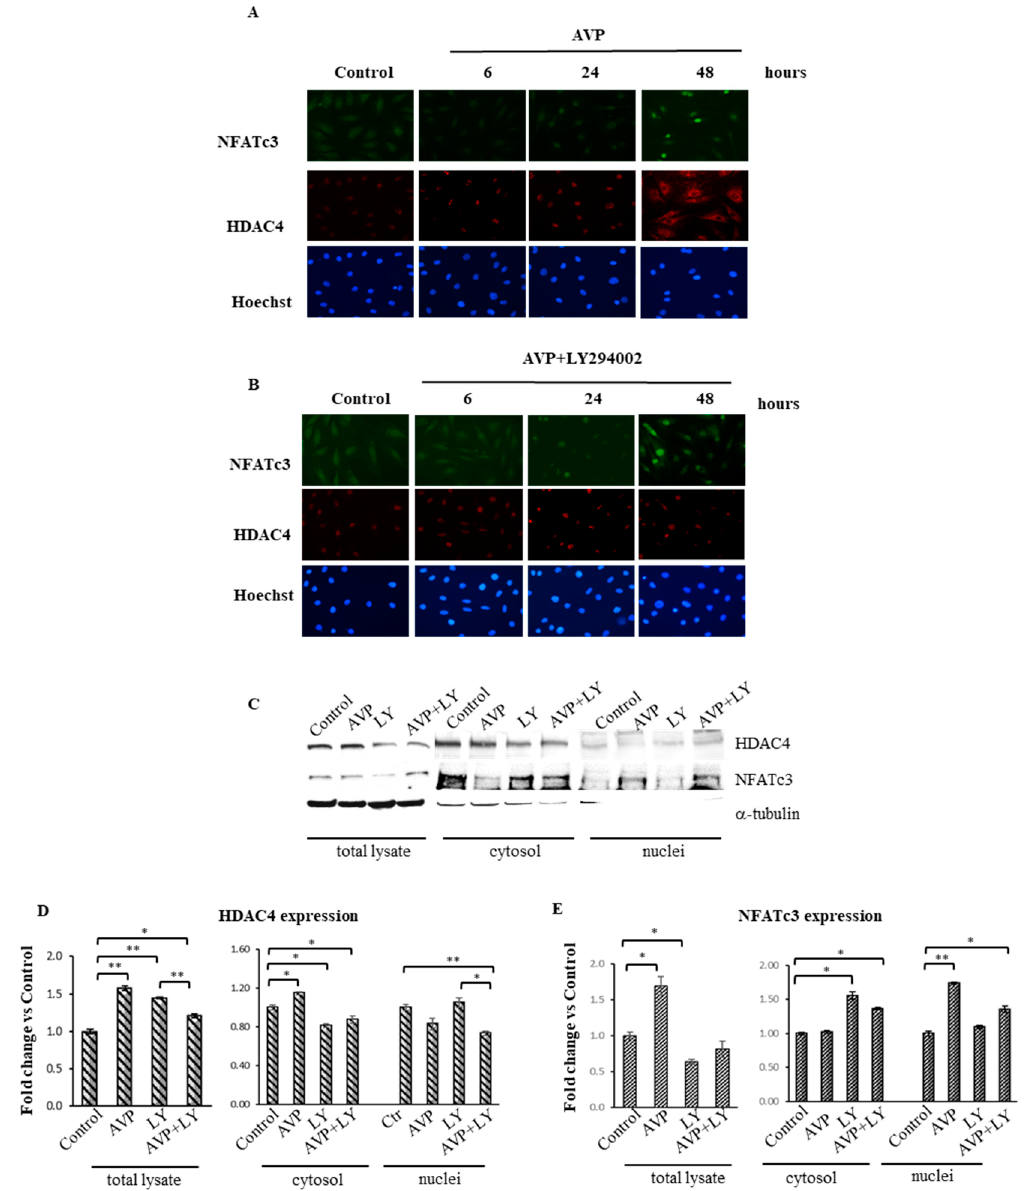
Figure 7. HDAC4 and NFATc3 expression / cellular localization are modulated by LY294002 in AVP-treated L6 cells. L6 cells were cultured in growth medium and after 24 h were shifted in serum-free medium and treated with 0.1 µ M AVP in the presence and in the absence of 20 µ M LY294002 for 48 h. ( A , B ) Immunofluorescences analysis was performed to evaluate the expression levels and cellular localization of HDAC4 and NFATc3 (original magnification 20 × ). ( C ) Western Blot analyses of total lysates and cytosolic and nuclear fractions were achieved to evaluate changes of cellular localization of HDAC4 and NFATc3 after LY294002 addition in AVP-treated and un-treated L6 cells. ( D ) Densitometric analyses were performed using an anti- α -tubulin antibody to verify the equal loading of the samples and the cytoplasmic contamination of the nuclear fractions. Nuclear and cytosolic fractions were normalized using Stain-Free technology. Representative blots are shown. Statistical analysis was performed by Student’s t -test on data obtained from three independent experiments. * p < 0.05; ** p < 0.01.